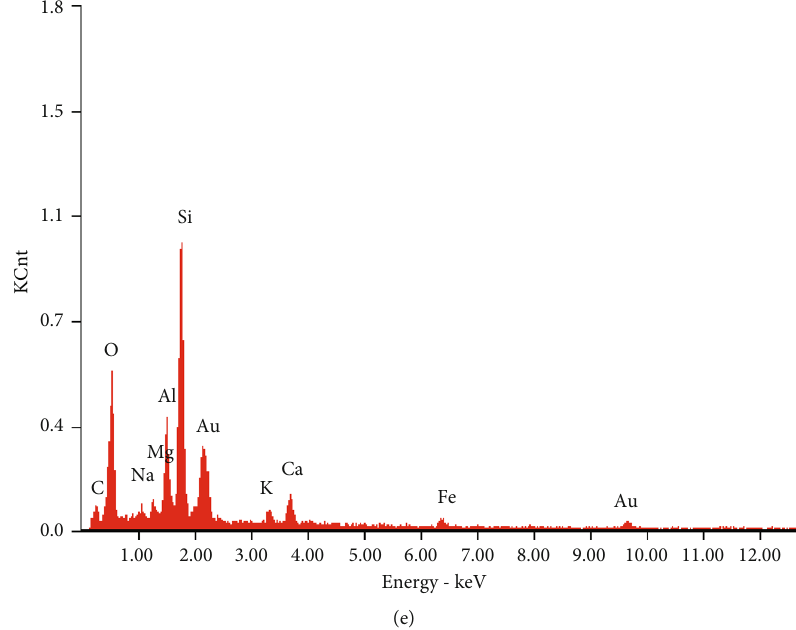
Figure 12: EDX spectra of (a) untreated soil, (b) soil with 0.75% PF, (c) soil with 1.5% PF, (d) soil with 2.25% PF, and (e) soil with 3%